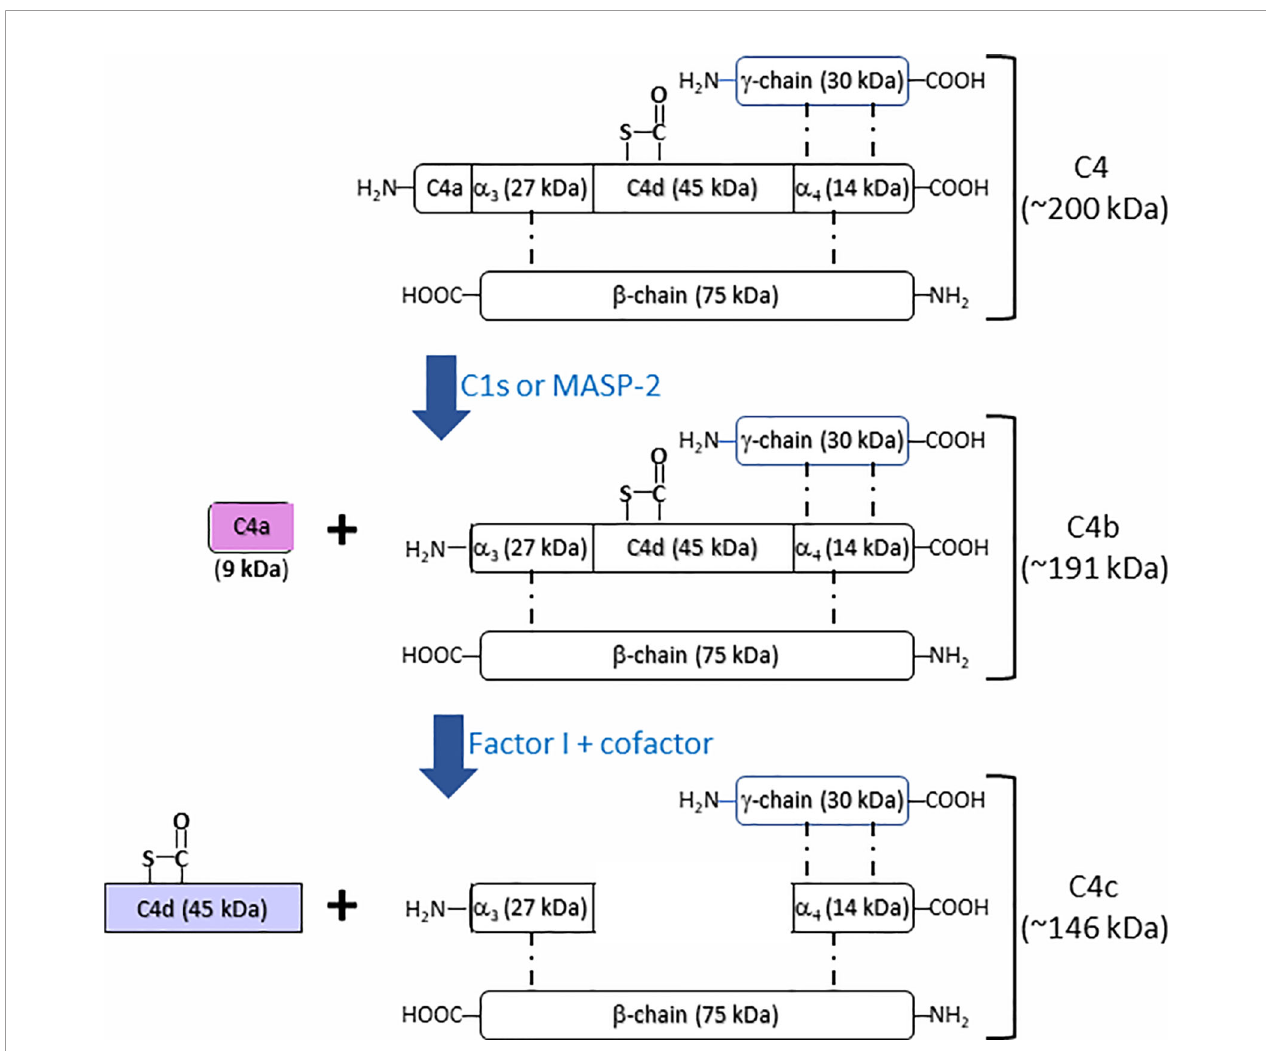
FIGURE 1 | Schematic illustration of fragmentation of complement C4 activation. Complement C4 (~200 kDa) is activated by the serine protease C1s or MASP2 from classical and lectin complement pathway, respectively, to form the activation fragments C4a (~9 kDa) and C4b (~191 kDa). C4b (~191 kDa) is then inactivated and cleaved by the factor I together with cofactors to generate intermediate product iC4b and then further to generate the thioester linked C4d (~45 kDa) and C4c (~146